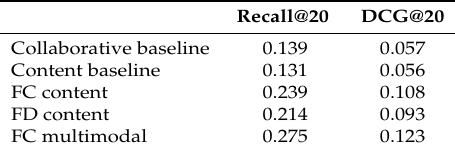
Table 6. Experiments on MovieLens with DBPedia content, all methods using Jaccard